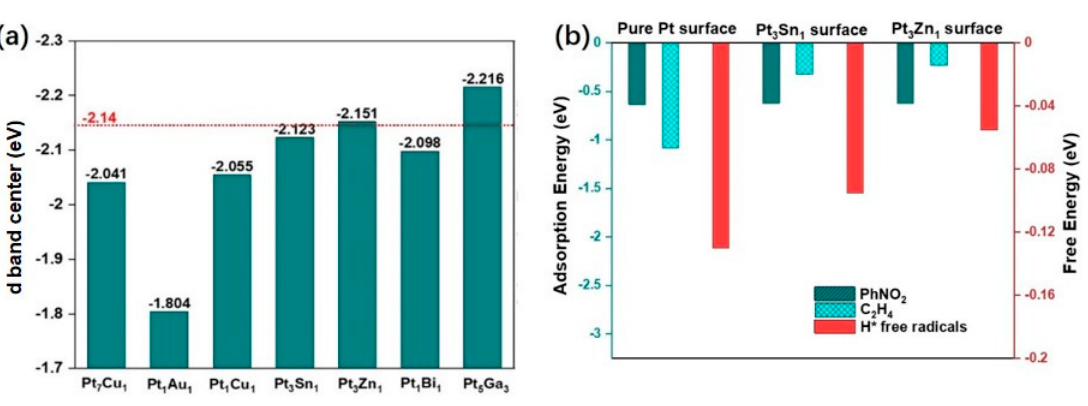
Figure 7. ( a ) The d-band center values of different Pt-based alloys. ( b ) The adsorption performances of pure Pt, Pt 3 Sn 1 , and Pt 3 Zn 1 on PhNO 2 , C 2 H 4 , and H*, respectively.